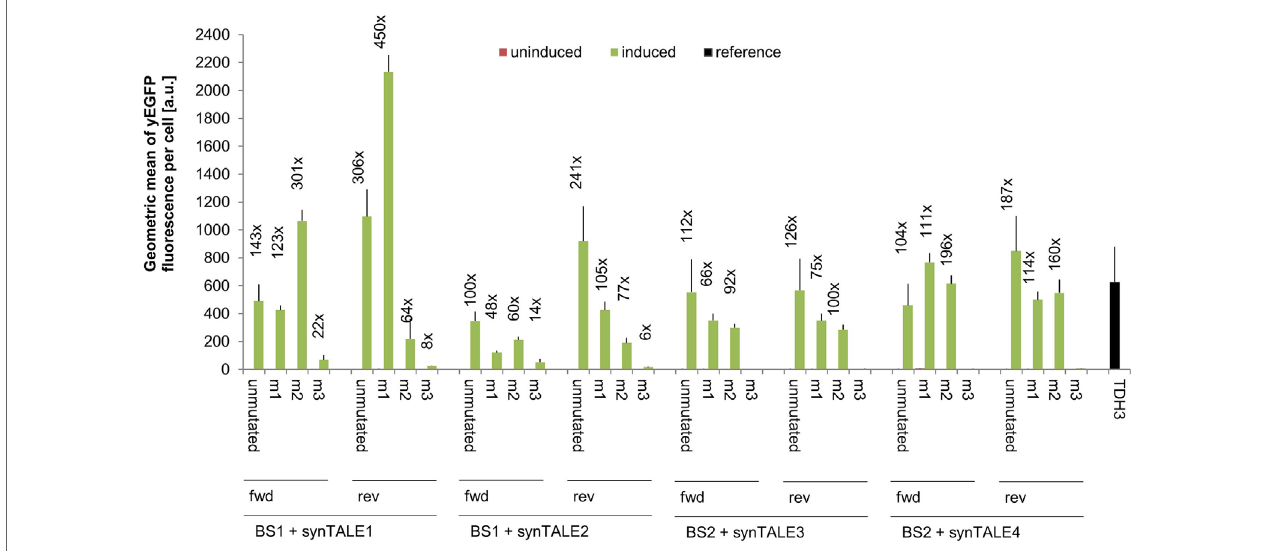
FigUre 3 | Mismatches in synthetic transcription activator-like effector (synTALE)-binding sites (BSs) in most cases gradually reduce the transactivation capacity. SynTALE1–4 were tested for transactivation of yEGFP expression from synthetic promoters (synPs) containing mutated versions (m1, m2, and m3) of their cognate BS. SynTALE expression was induced with IPTG in galactose containing medium. Background activity of synPs was measured in glucose containing medium without IPTG. Values from uninduced samples are always very low. Induction of at least 2-fold is indicated. Fwd, forward orientation; rev, reverse orientation; a.u., arbitrary